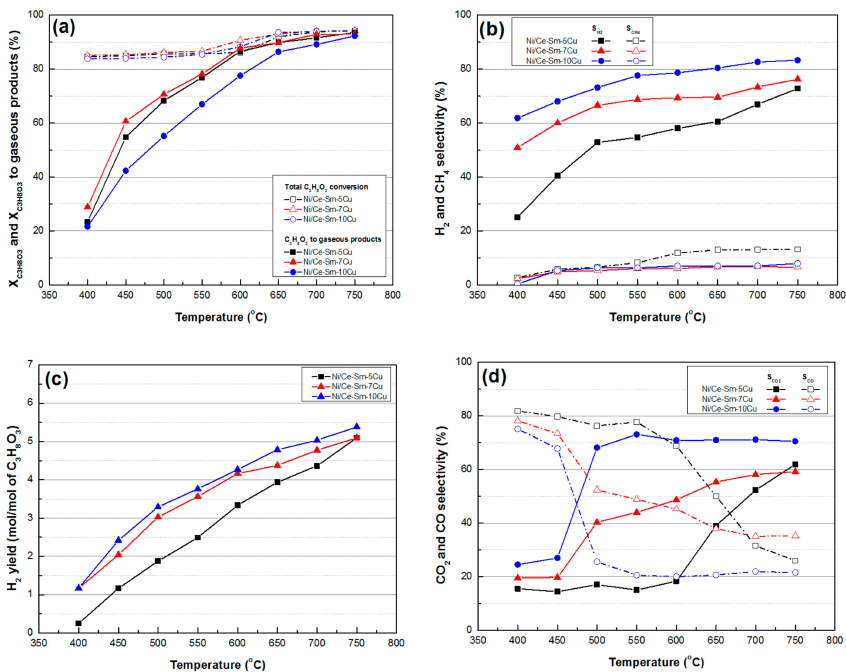
Figure 10. ( a ) Total glycerol conversion and glycerol conversion into gaseous products; ( b ) H 2 selectivity and CH 4 selectivity; ( c ) H 2 yield; ( d ) CO 2 and CO selectivity [Results obtained for samples tested under experimental protocol